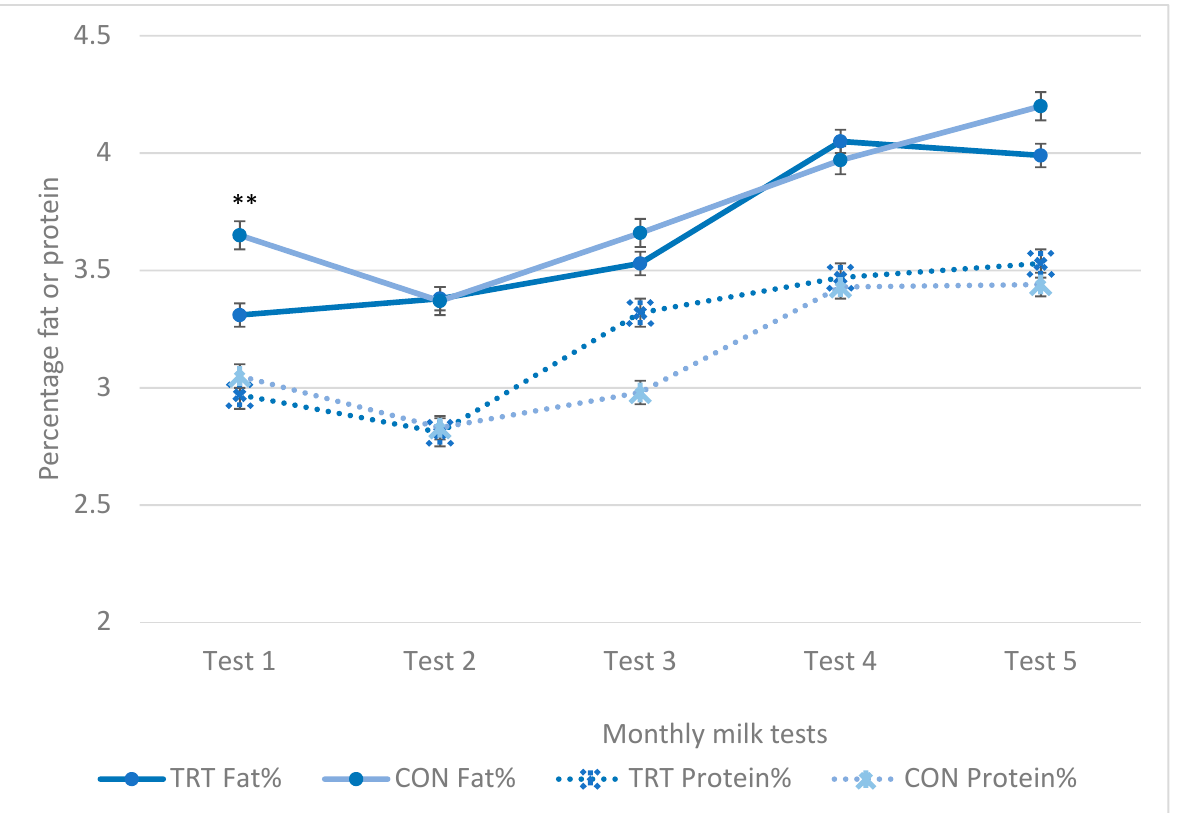
Figure 2. Distribution of milk fat% and milk protein% across the monthly milk test days among cows in the treatment (TRT; no headlocks) and control (CON; regular headlock) groups. ** denotes a statistically significant difference. Table 1. Distribution of pregnancy per AI and cumulative frequency of diseases among the cows in treatment (TRT = no headlocks) and control groups (CON = regular